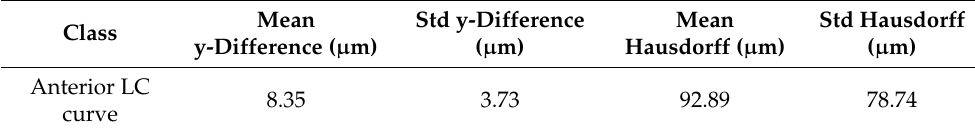
Table 2. The anterior LC curve prediction by applying the segmentation algorithm.